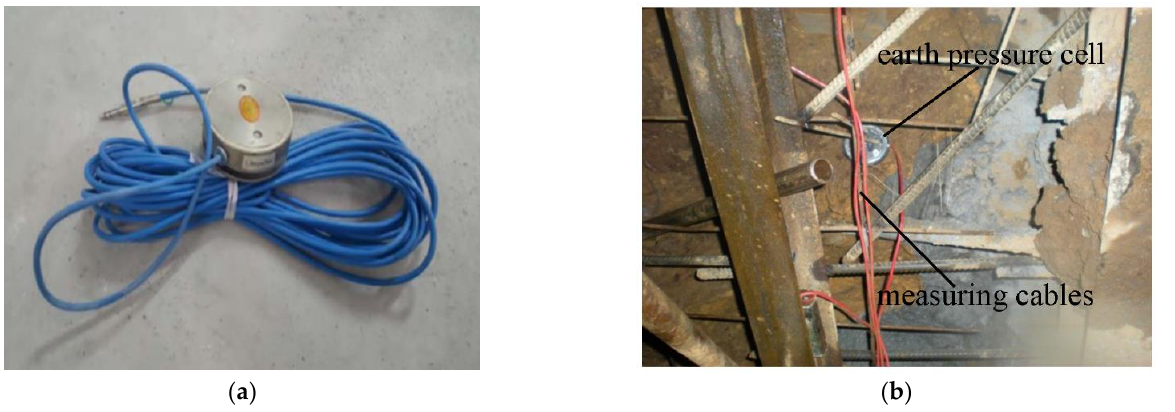
Figure 9. Installation of field monitoring instruments: ( a ) XYJ-4 type vibrating wire double diaphragm pressure cell; ( b ) installation of earth pressure box.